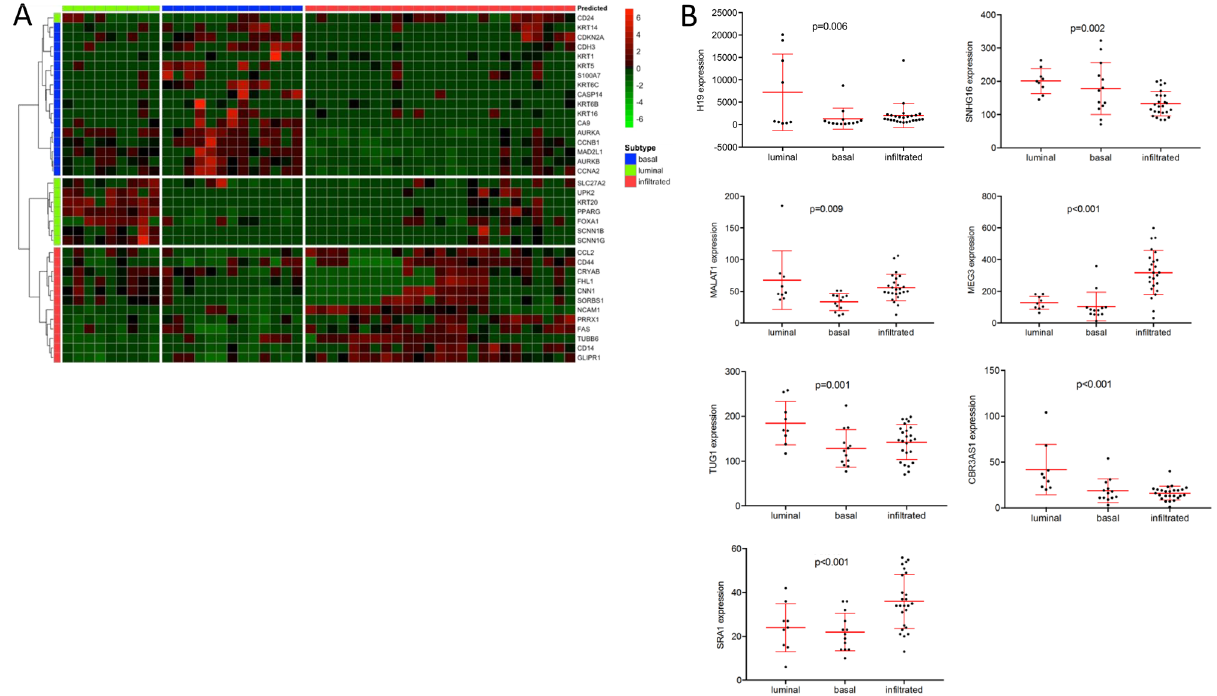
Figure 1. ( A ) Heatmap of the Mannheim cohort (n = 47) clustering patients into the basal, luminal and infiltrated subtypes based on the in-house 36-consensus gene panel ( B ) LncRNAs with significant differential expression between the molecular MIBC subtypes based on the Mannheim